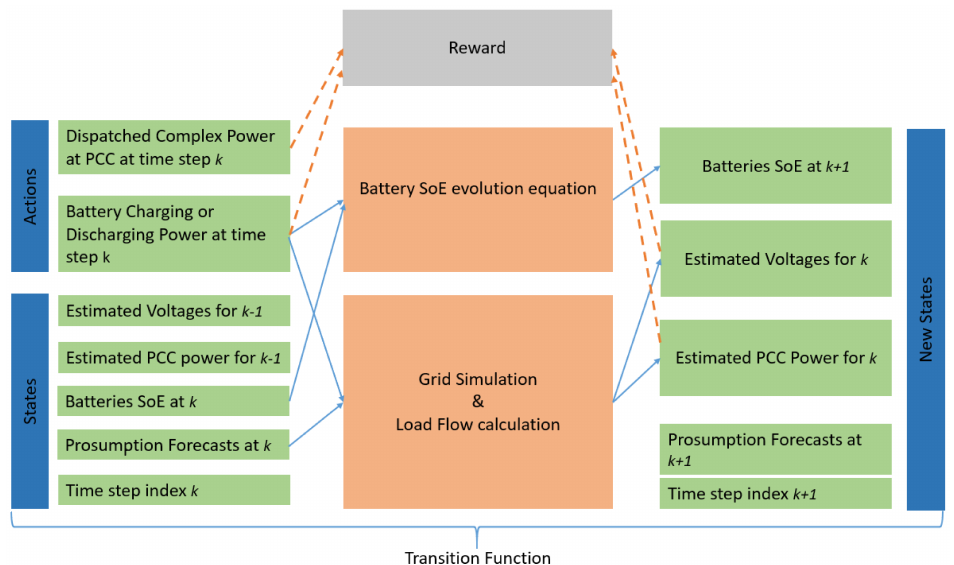
Figure 3. Transition function from one state to the next and inputs for computing the